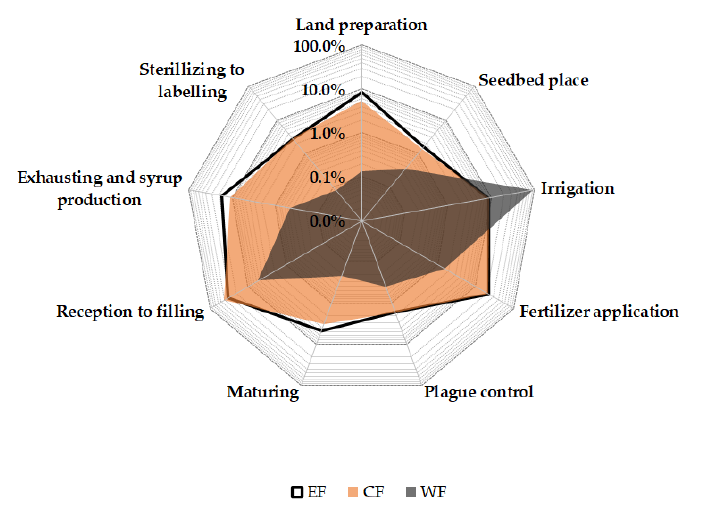
Figure 10. Carbon, water, and energy footprint of pineapples in syrup by main unit processes.